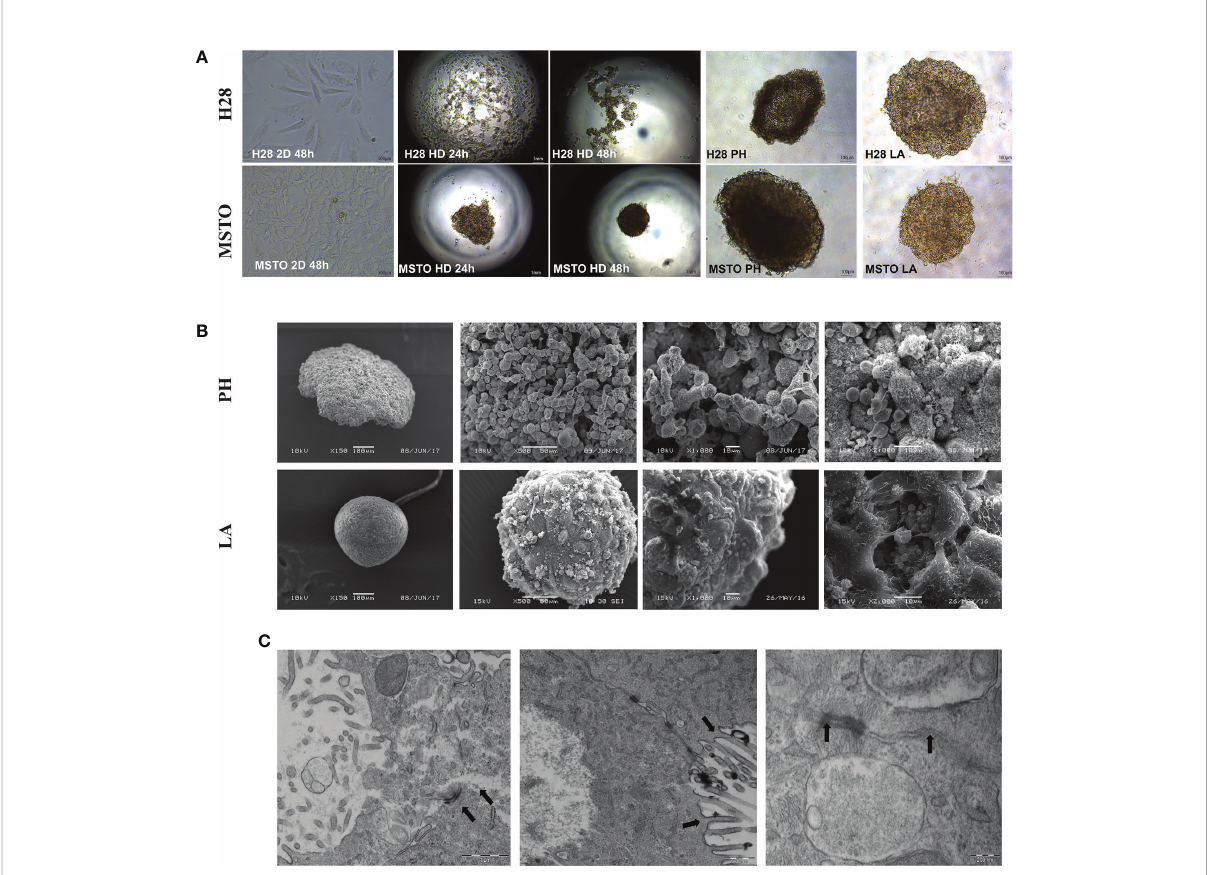
FIGURE 1 Cancer cells are grown in 2D and 3D conditions. (A) H28 and MSTO tumor spheroids, hanging drop (HD), Poly-Hema (PH) and low adhesive plate (LA) were prepared in 3D and visualized using an inverted light microscope 24 and 48 h after 3D spheroid formation. (B) SEM was used to study the structure difference of cells grown in 3D using PH (top) and LA (bottom) methods. (C) TEM scanning revealed tight cell-to-cell junction and microvilli, indicated by black arrows in the LA spheroids. Scar bar =